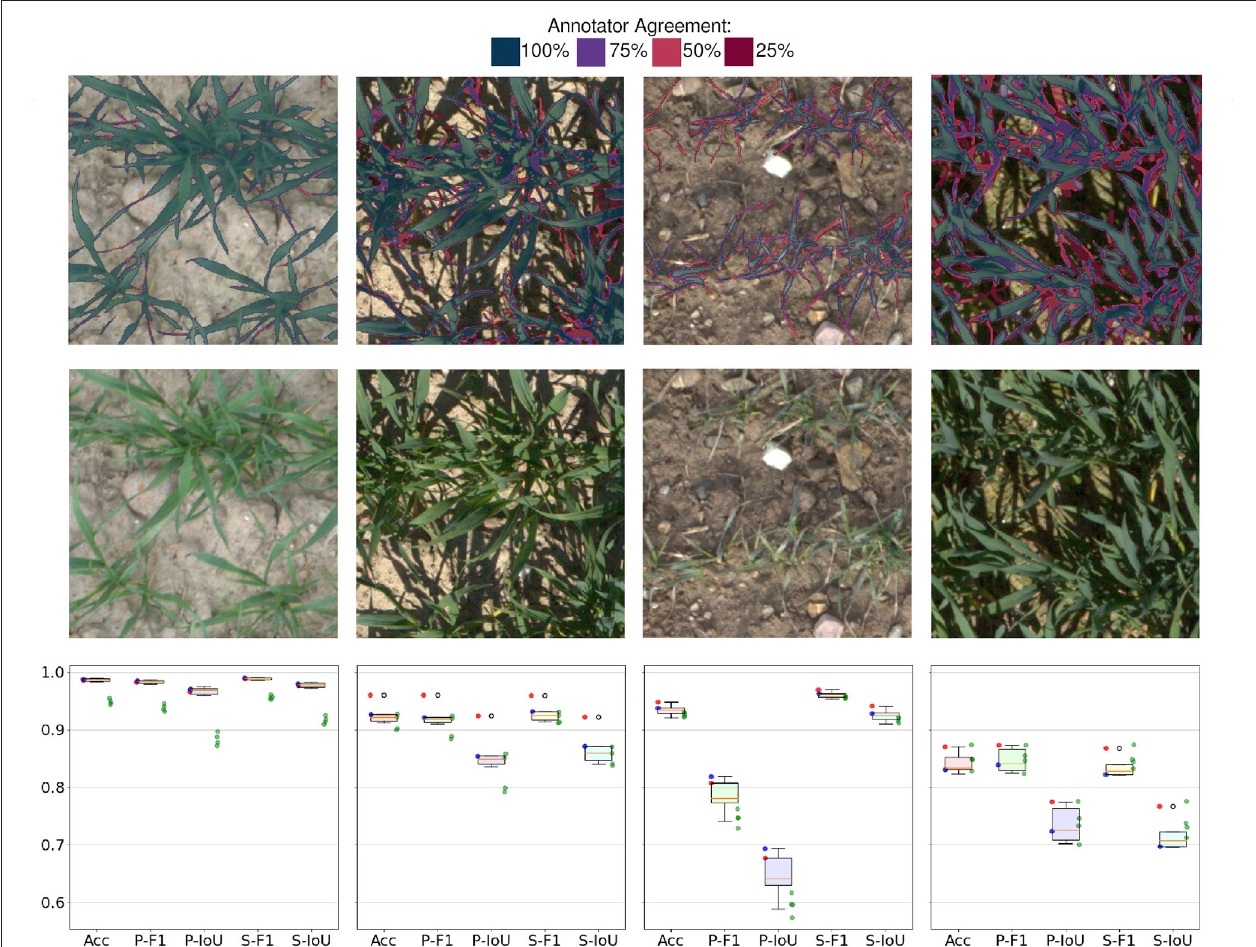
FIGURE 4 | The first row depicts the agreement of four different annotation attempts. The second row shows the original images. Please zoom in for details at the pixel level. Last row shows statistics of human annotations: Boxplot refers to 12 permutations of metrics resulting from 4 annotation attempts. Red and blue points refer to annotator 1 and annotator 2, respectively. Green dots show the performance of the proposed method. Acc: Accuracy, F1: F1-Score, IoU: Plants Intersection over union, prefix P stands for plants and prefix S for